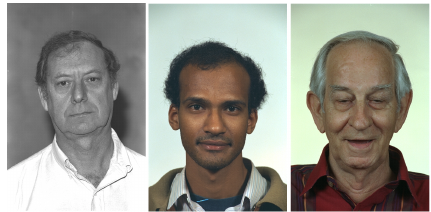
Figure 1. A sample of images from FERET